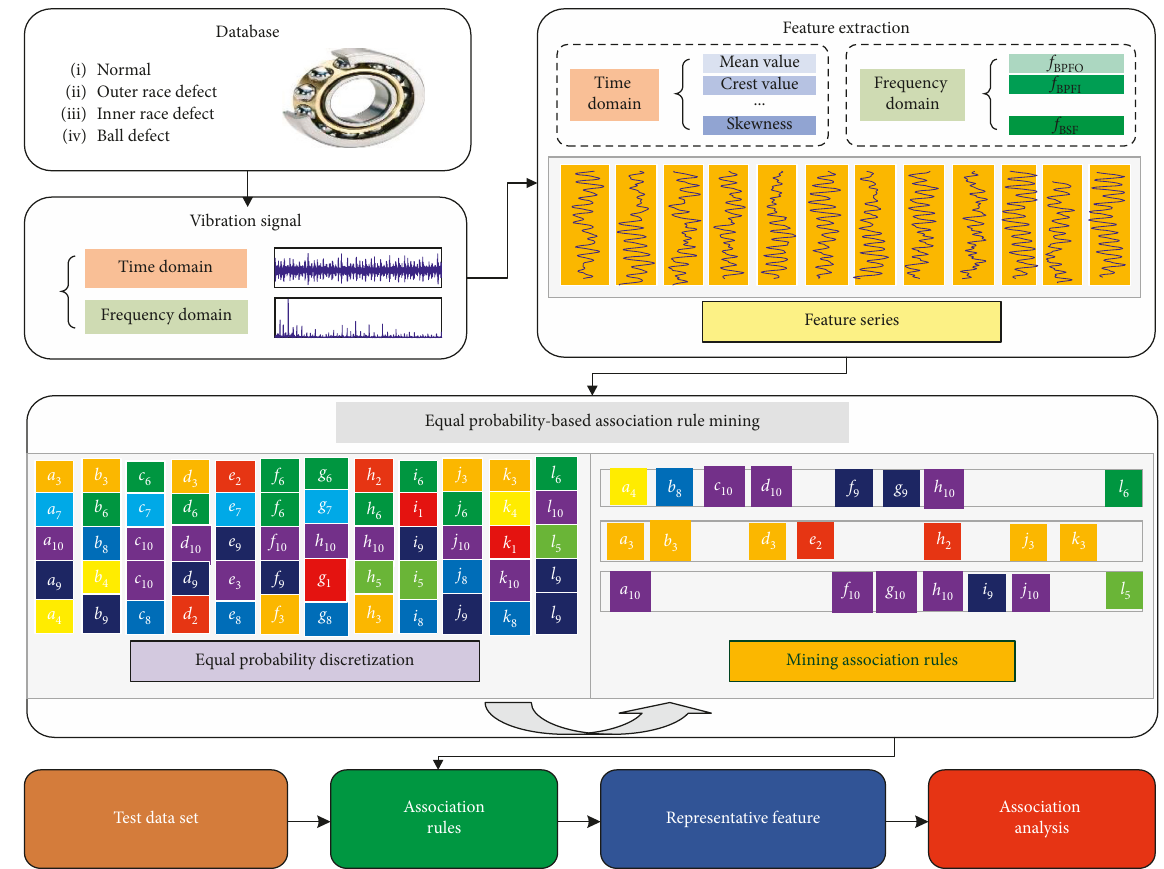
Figure 1: The framework of association rule mining for bearing defect diagnosis.